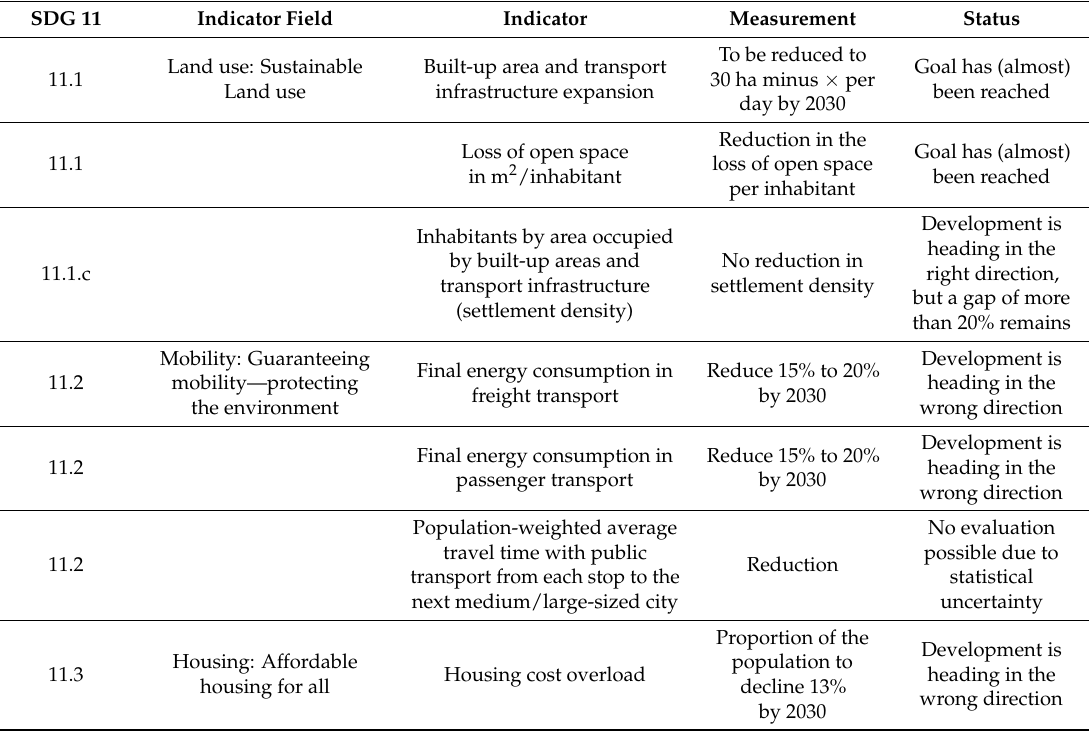
Table 1. Targets and Indicators addressing Goal 11 in the German National Sustainable Development Strategy